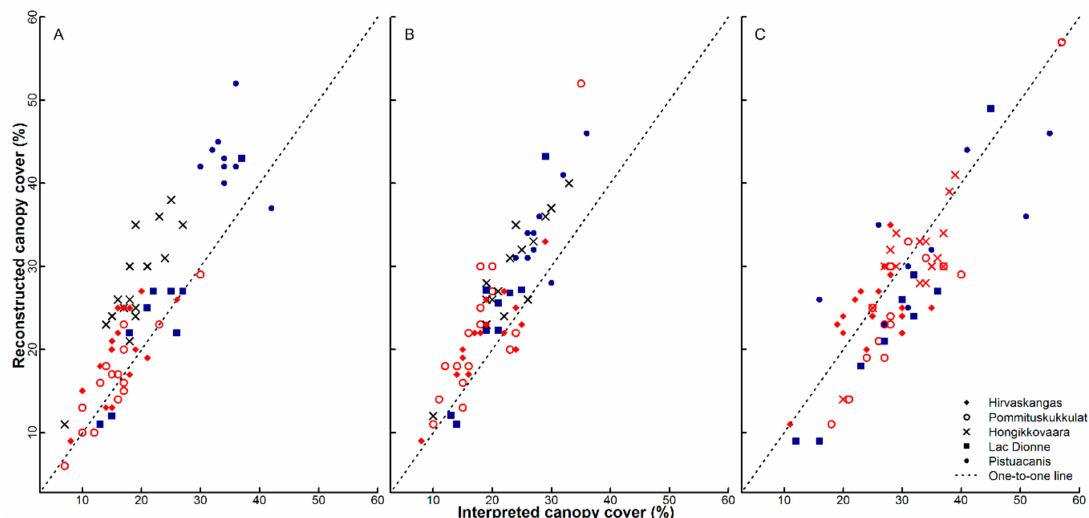
Figure 1. Comparison between the canopy cover reconstructed using the field and tree-ring measurements, and the visually interpreted canopy cover at the time of the: oldest aerial photographs ( A ); middlemost aerial photographs ( B ); and newest aerial photographs ( C ). The symbols indicate the landscapes, and the symbol colors indicate the landscapes which were calibrated using the same calibration